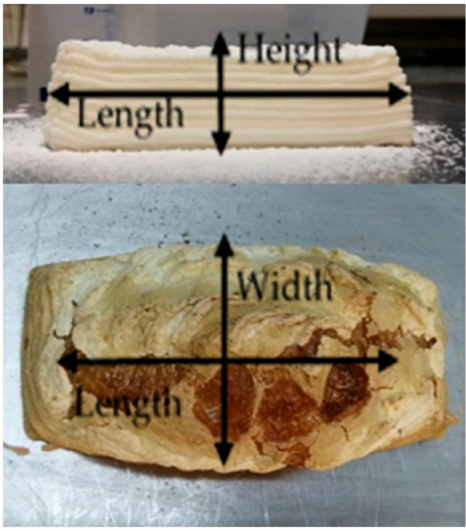
Figure 1. Sample data acquisition in image